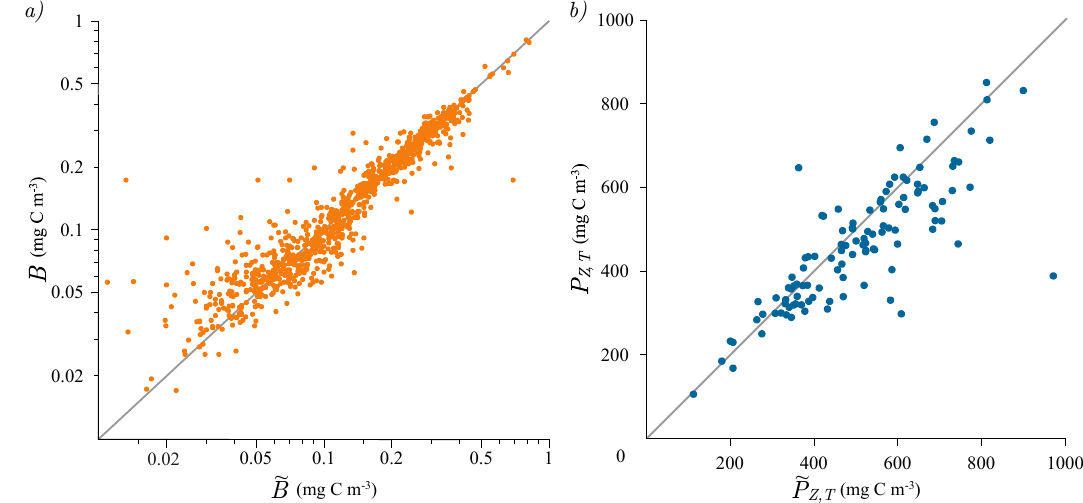
Figure 4. ( a ) Scatter plot of measured (cid:101) B and modelled biomass B with the shifted Gaussian function. There are, in total, 1049 points. ( b ) Scatter plot of measured (cid:101) P Z , T and modeled P Z , T watercolumn production with the analytical solution for the shifted Gaussian biomass. There are, in total, 138 points. The grey line on both plots represents the 1:1 model versus the measurement ratio. For the BATS station, the mean of the background biomass, B 0 , was 0.068 mg Chl m − 3 , with a standard deviation of 0.032 mg Chl m − 3 . The mean depth of the deep biomass maximum, z m , was 99 m, with a standard deviation of 21 m. The mean width of the biomass peak σ was 22 m, with a standard deviation of 12.5 m and finally, the mean height of the biomass peak, H , was 0.377 mg Chl m − 3 , with a standard deviation of 0.265 mg Chl m − 3